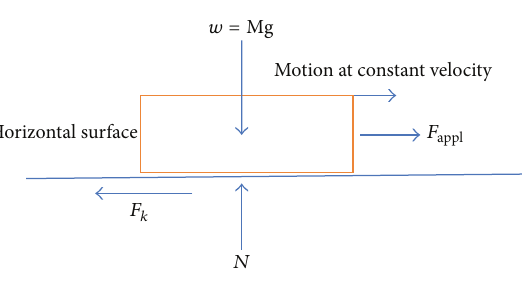
Figure 4: Coefficient of friction evaluation.